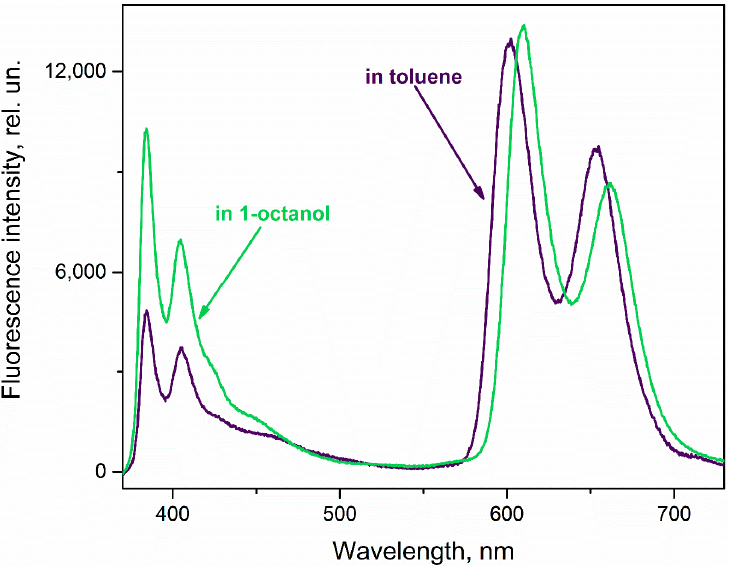
Figure 9. The fluorescence spectra of ZnPIP solutions (9.0 × 10 − 7 M) in toluene and 1-octanol ( λ ex = 346 nm).